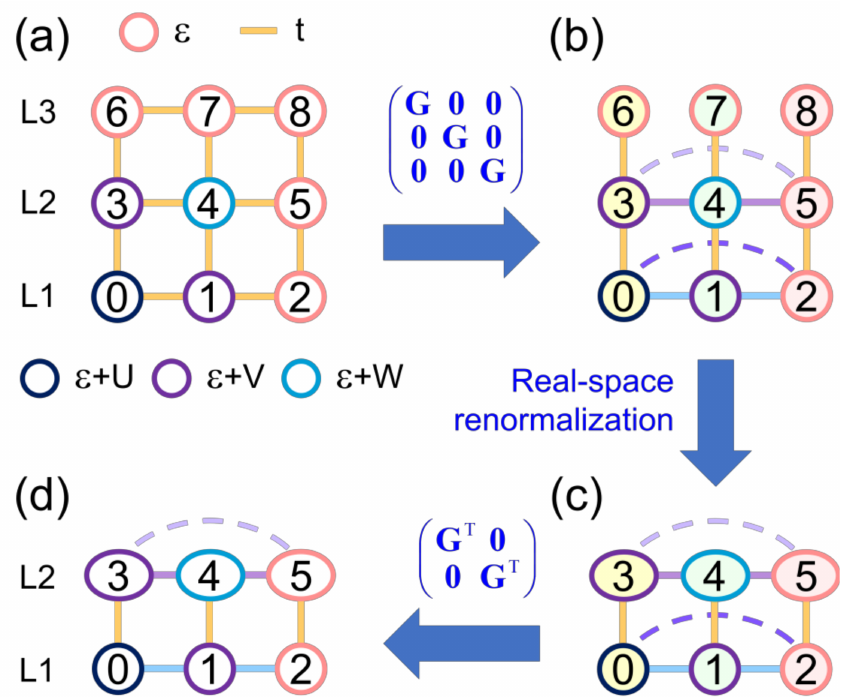
Figure A1. (Color online) ( a ) Square lattice of 3 × 3 excitonic states with local (U) and non-local (V, W) electron-hole interactions of Hamiltonian (1); ( b ) After applying a unitary transformation, appear three independent chains 3–6, 4–7 and 5–8, as well as new hopping connections on L1 and L2 levels; ( c ) Via a renormalization procedure, sites 6, 7 and 8 were eliminated but their participation is preserved through the new self-energies of sites 3, 4 and 5 illustrated as ellipses; ( d ) Final excitonic lattice after an inverse unitary transformation, where the sites on L2 remain totally interconnected while those on L1 restore to their original